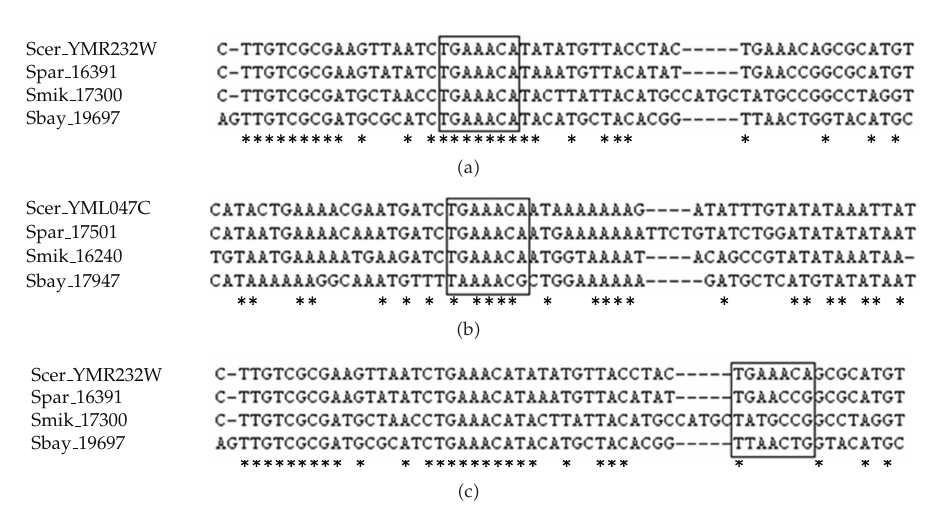
Figure 1: DNA binding motif TGAAACA of transcription factor STE12 . The known DNA binding motif TGAAACA of transcription factor STE12 for S. cerevisiae genes YML047C (cid:2) a (cid:3) , YLR452C (cid:2) b (cid:3) , and YCL055W (cid:2) c (cid:3) is conserved in the alignment of orthologous gene promoter regions of closely related yeast species, namely, S. cerevisiae , S. mikatae , S. bayanus, and S. paradoxus